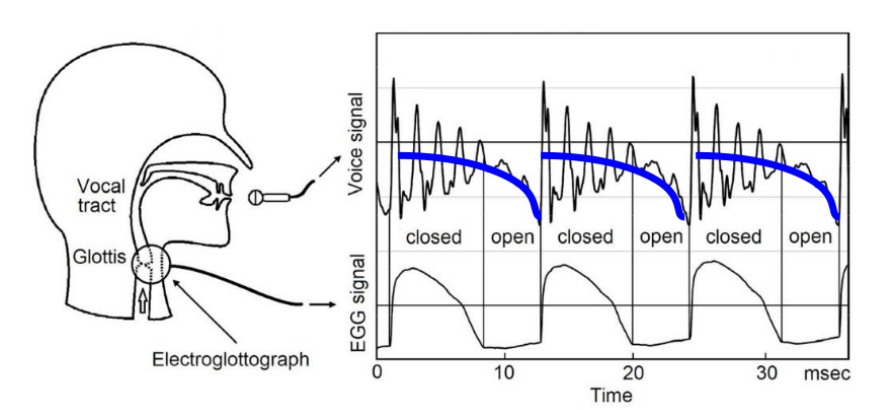
Figure 1. (After [12,16]; reproduced with kind permission.) The EGG signal is the electrical conductance between two electrodes placed on the neck. When the glottis is closed, the measured conductance is high, and vice versa. The EGG signal is displayed in the bottom panel. In the top panel the synchronized speech waveform is plotted and three individual pitch periods are shown. From comparing the top and bottom panel, it is evident that the pulses in the speech waveform occur when the EGG signal rises sharply; i.e., when the glottis closes. Additionally, there are two phases (closed-open) within each pitch period in which the damping of the speech waveform seemingly changes; this is primarily due to the glottal waveform which becomes prominent at the end of the pitch periods as the glottis is reaching its maximum aperture. The blue baseline drawn in the top panel by simple visual inspection is related to the time derivative of the glottal flow (dGF). A second and smaller effect causing the pitch periods to exhibit two phases is the extra coupling to the subglottal cavities (such as the lungs) of the acoustic waves in the VT when the glottis opens; this causes these waves to decay